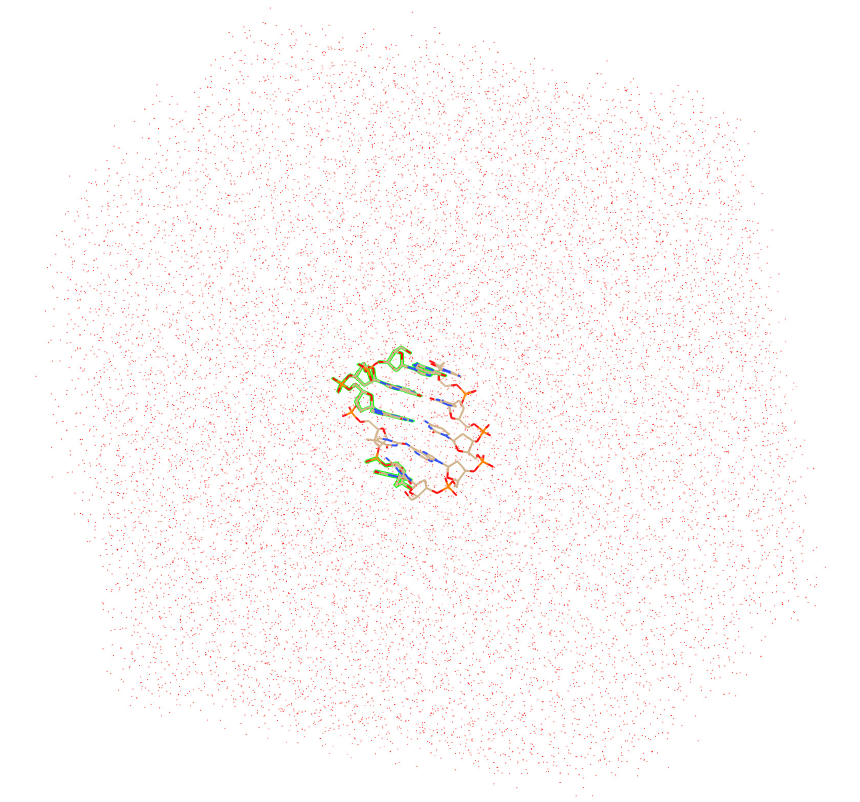
Figure 2. Optimized structure of 5 (cid:48) -GGGTG-3 (cid:48) double strand immersed in a box consisting of ca . 15,000 water molecules. Hydrogen atoms have been omitted for clarity. Water molecules are depicted as red dots. Guanine nucleobases included in the QM layers of ONIOM computations are highlighted with a green border.